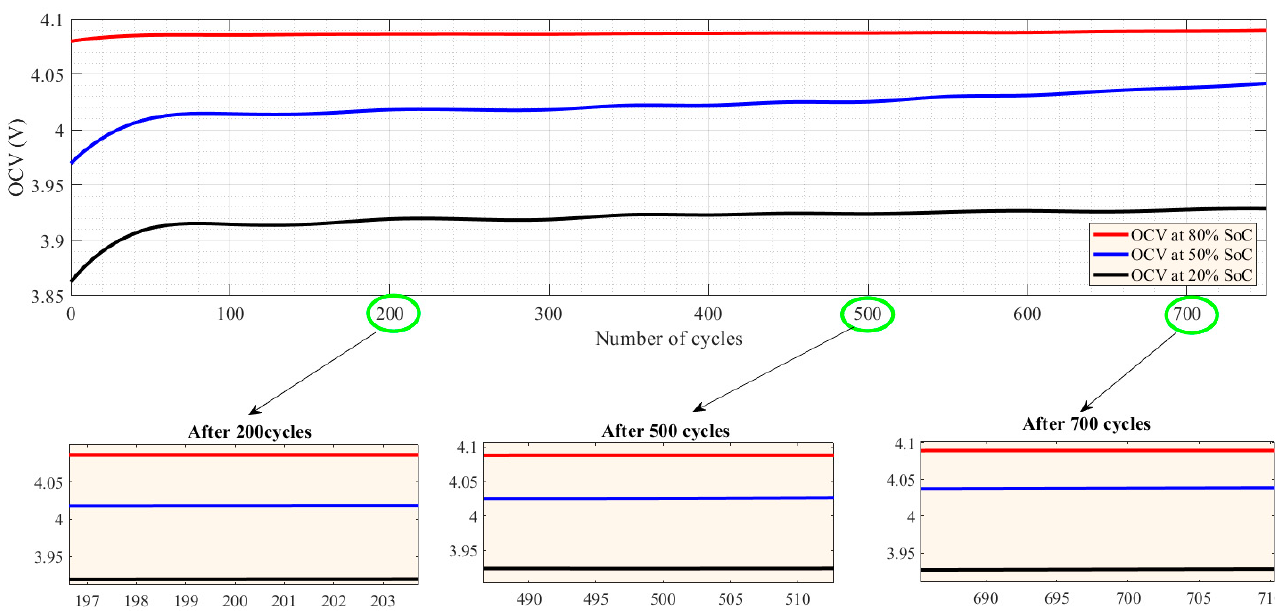
Figure 9. Comparison of the OCV pattern at 25 °C under C/2 charge and C/5 discharge test conditions.